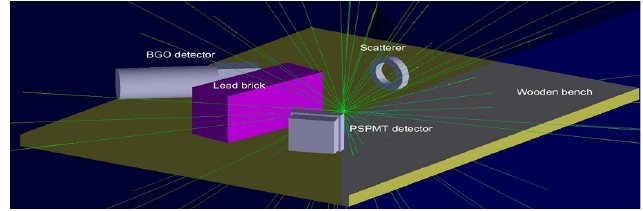
Fig. 10: GEANT4 Geometry of coincidence set-up of BGO and LaBr 3 (Ce)- PSPMT detectors with a scatterer for Compton back-scattering imaging.